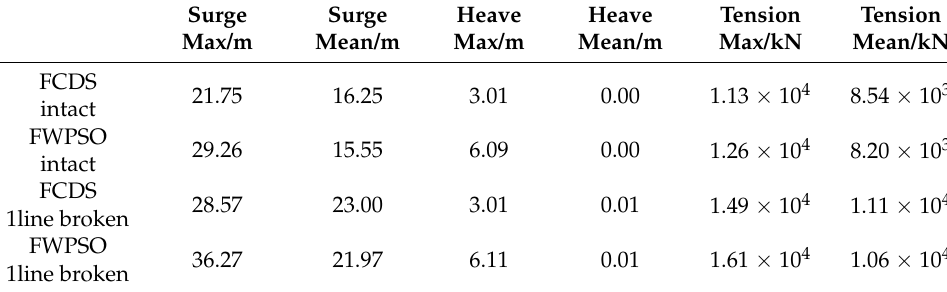
Table 6. Statistic results of buoy motion and mooring